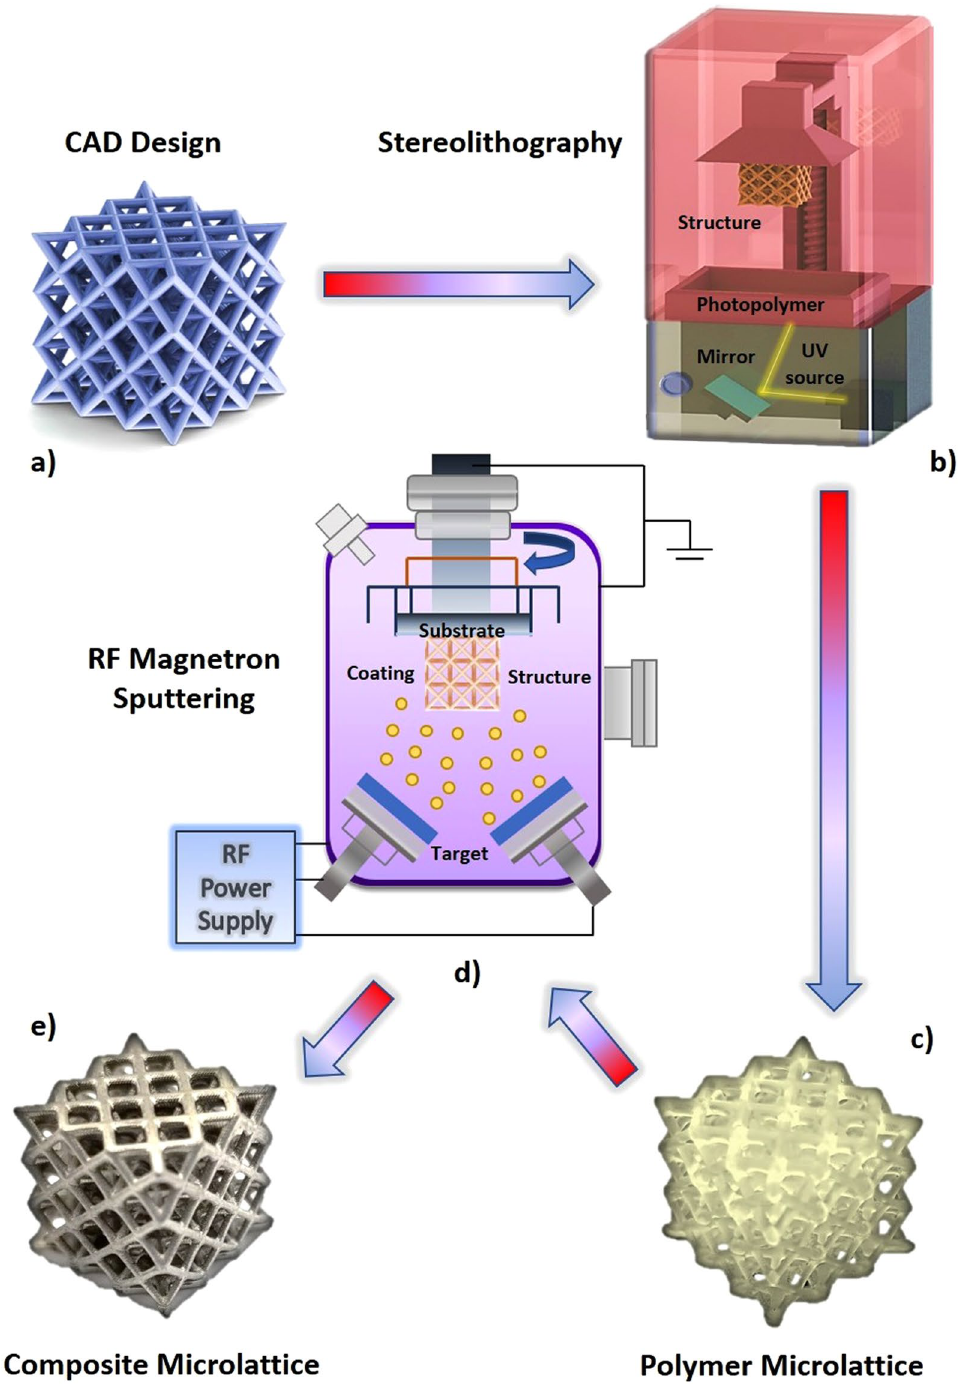
Figure 1. Schematic illustration of the synthesis of HEA-coated microlattices. ( a ) 3D CAD design of the structure used. ( b ) Fabrication process of the 3D polymer template by stereolithography. ( c ) Optical image of the synthesized pure polymer microlattice. ( d ) The HEA thin film coating deposition process onto the polymer structure by RF magnetron sputtering. ( e ) Optical image of the core-shell polymer/HEA microlattice